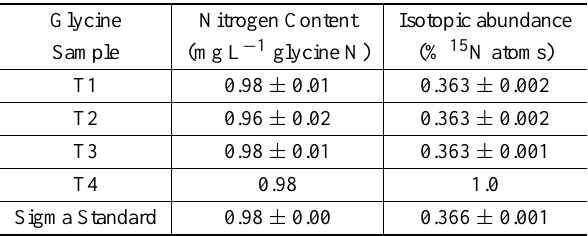
Sigma Standard 0.98 ± 0.00 0.366 ± 0.001 T1, T2, and T3 = mean and standard deviation of the mean for samples synthesized from 50, 100, and 150 mL NH 3(aq) , respectively; T4 =